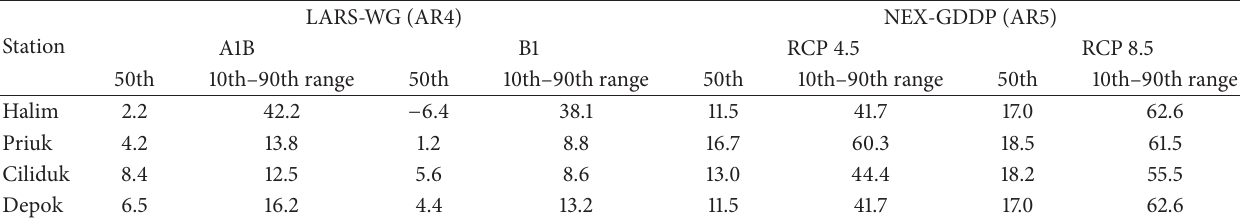
Table 4: Comparison of median (50th) and interpercentile range (10th to 90th) of percentage changes in 100-year RP daily rainfall for LARS- WG and